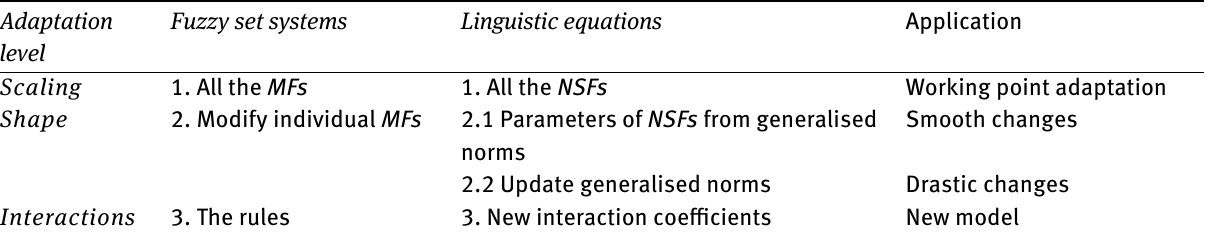
Table 2: Adaptation